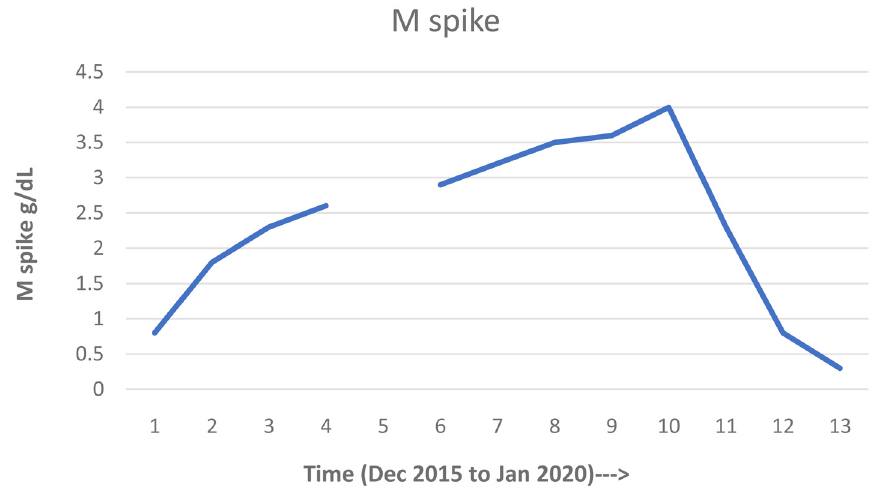
Figure 1. Graphical trend of M